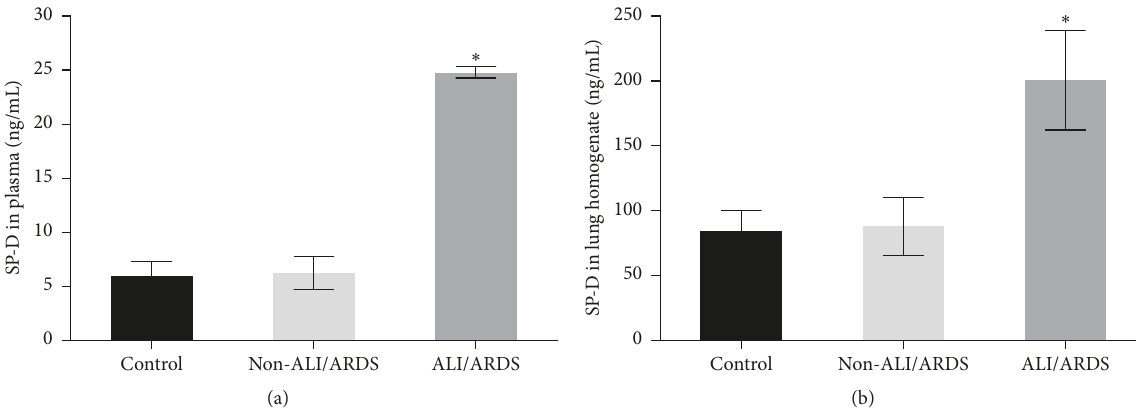
Figure 3: SP-D levels in the plasma and lung homogenate from the malaria-infected mice with ALI/ARDS, malaria-infected mice in the non-ALI/ARDS group, and mice in the control group (n = 5 mice per group). (a) SP-D in the plasma and (b) SP-D in the lung homogenates. ∗ Significance of p < 0.05 compared among groups using Kruskal–Wallis test. The data are presented as the mean ± SEM.